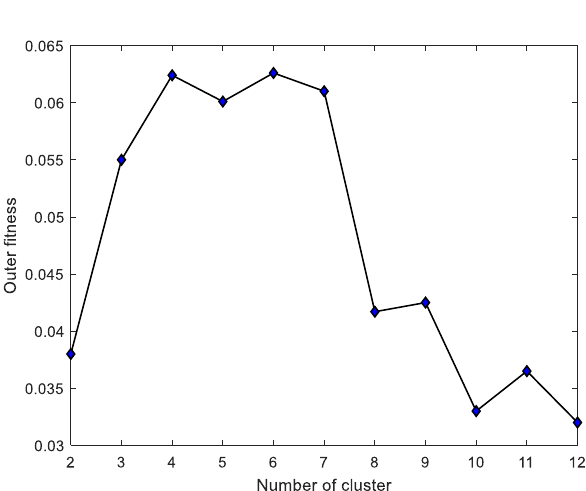
Figure 4. Relationship between J m , D, and the number of clusters.